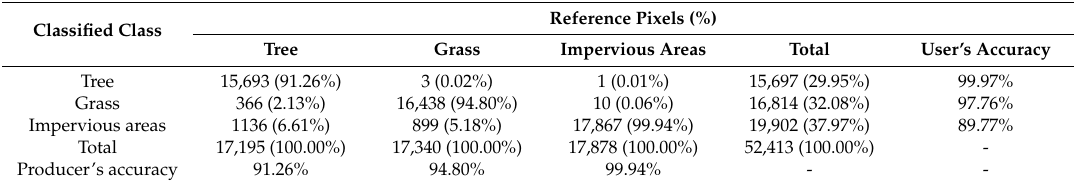
Table 2. Classification accuracy